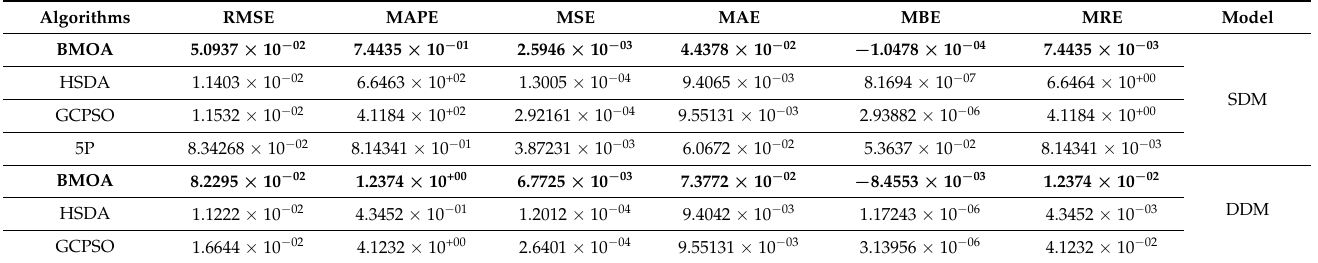
Table 16. Sharp ND-R250A5 photovoltaic panel (SDM and DDM) statistical tests.